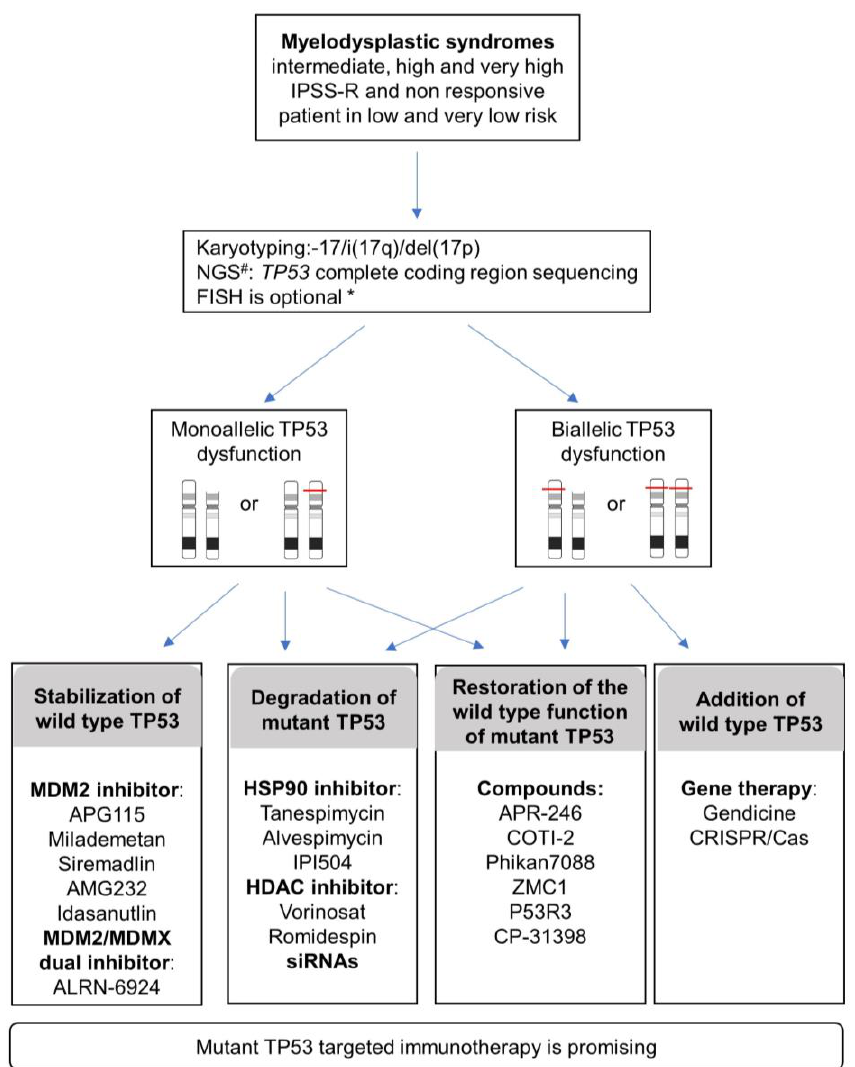
Figure 3. Proposed diagnosis strategies and current TP53-targeting strategies reported in various cancers and that could be applied to MDS patients in IPSS-R intermediate, high, very high risk, and non-responsive patients in very low and low risk. # NGS, Next-Generation Sequencing; * FISH, Fluorescent in situ hybridization. FISH is advised under the following conditions: <20 metaphases or unresolved metaphases or one abnormal metaphase or balanced changes involving breakpoint at 17p13. Specific pipelines of NGS analysis allow assessment of allelic imbalances (gains, deletions, cnLOH) in addition to identifying variants.